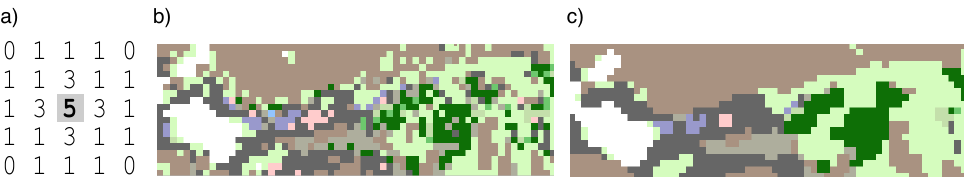
Figure 7. ( a ) The weight matrix for the 5 × 5 pixel filter. ( b ) The original classification image and ( c ) its filtered counterpart after applying the 5 × 5 pixel filter (random